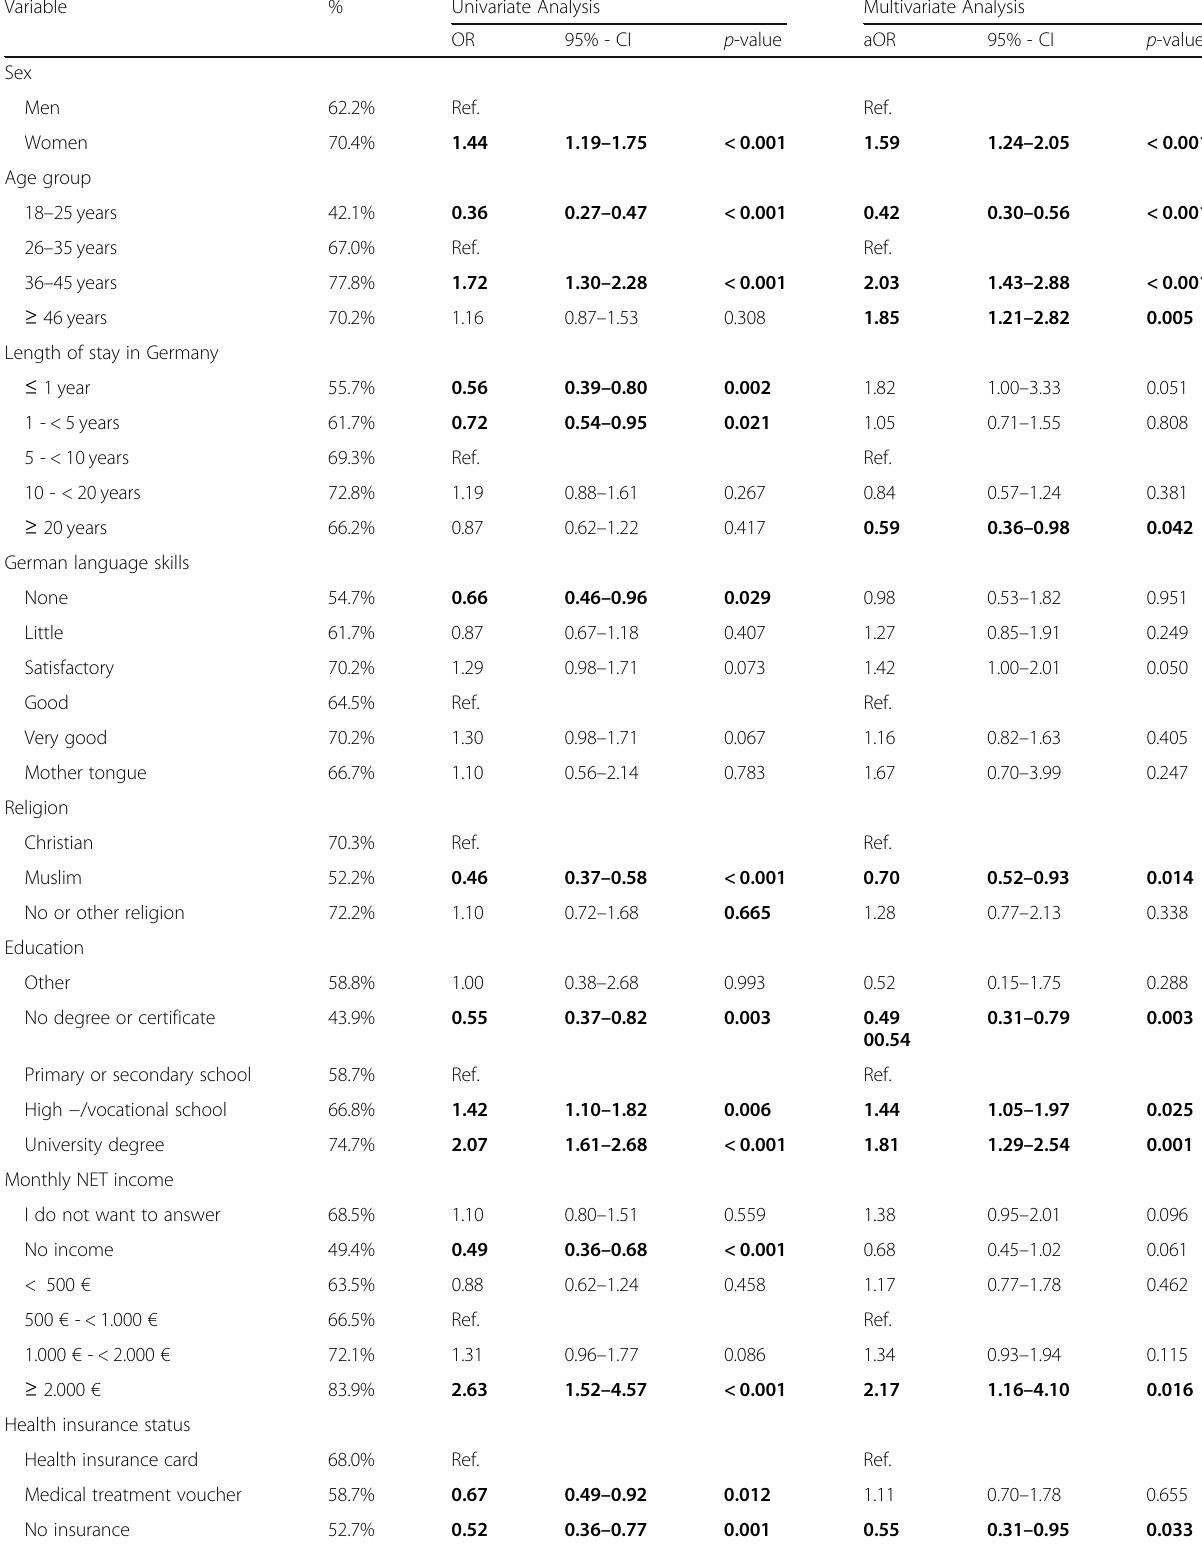
Table 7 Multivariate analysis on HIV test uptake (ever been tested = 1, not tested = 0), n =